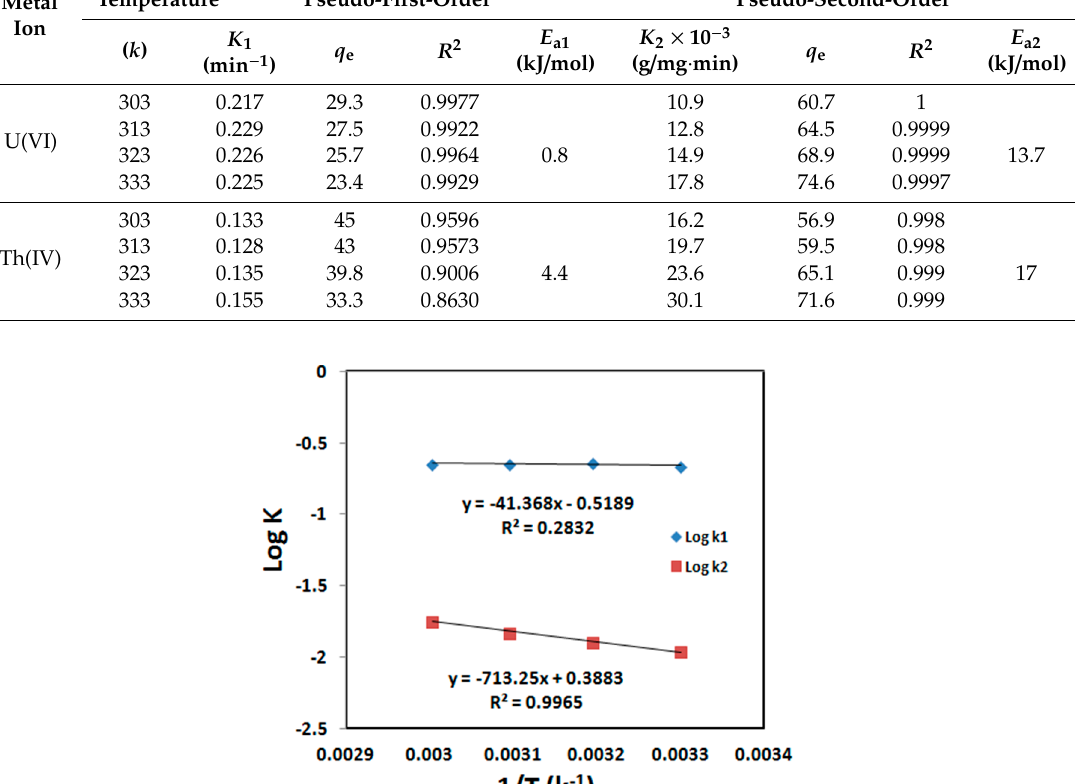
Table 3. Adsorption kinetics parameters of the pseudo-first-order model and pseudo-second-order model for U(VI) and Th(IV) sorption onto HQ-bentonite at di ff erent temperatures.